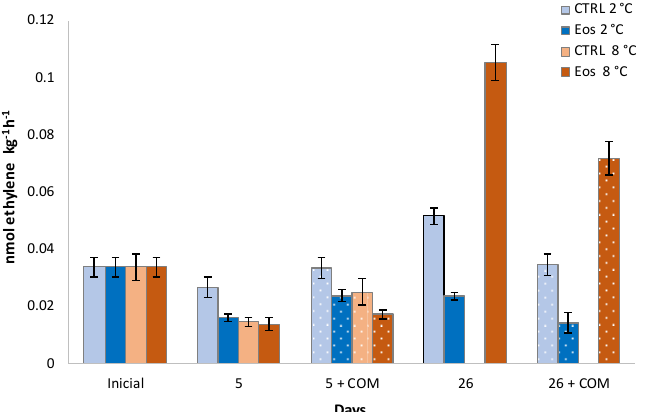
Figure 3. ACO activity during cold storage periods (2 and 8 °C) and complimentary commercialization simulations (COM; 4 days at 22 °C) of flat peaches with or without active paper sheets (including βCD-encapsulated EOs) ( n = 3 ± SD).